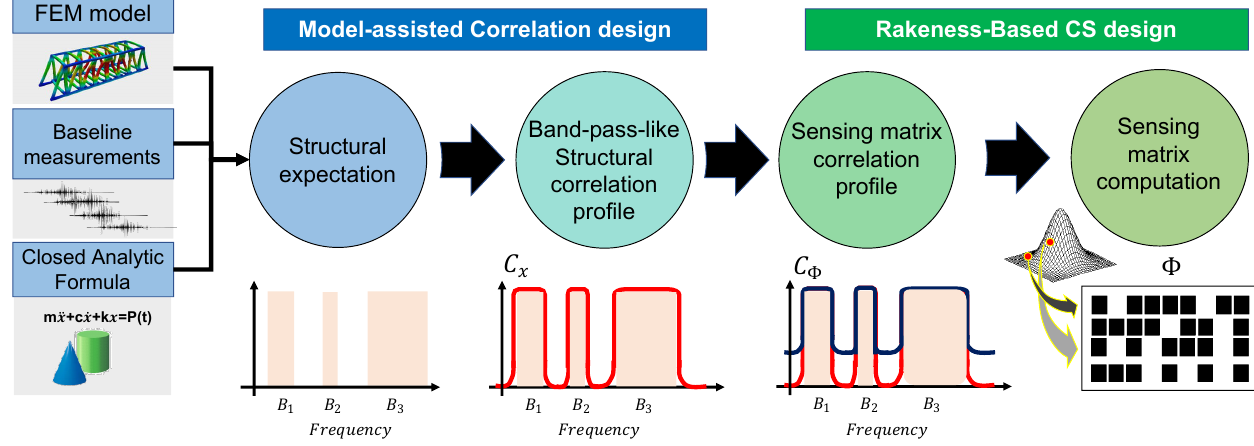
Figure 2. General processing flow at the basis of the MRAK-CS